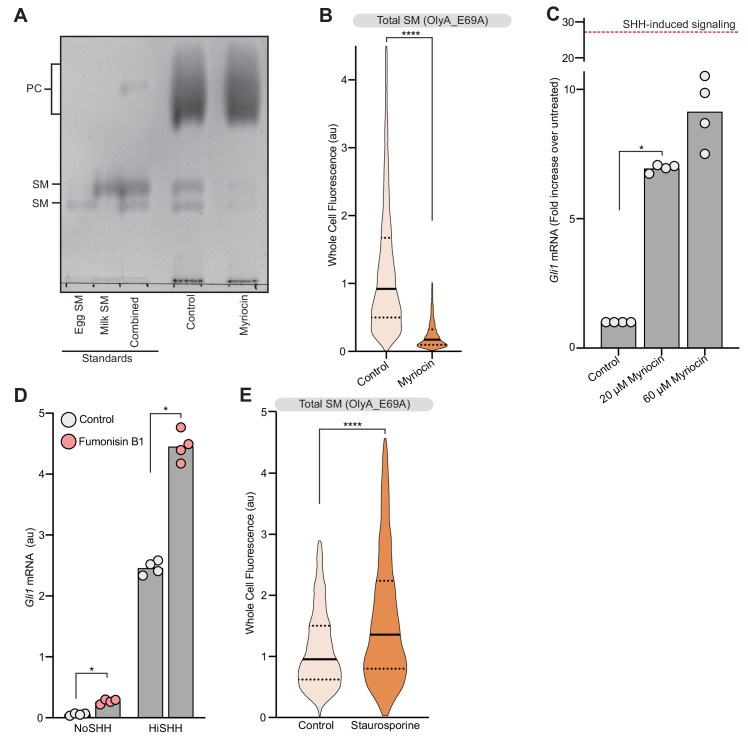
Analysis of sphingomyelin levels and their effect on hedgehog signaling.(A) Thin Layer Chromatography was used to measure SM and phosphatidylcholine (PC) levels in cells treated with myriocin. Purified egg and milk sphingomyelin were used as standards. (B) Flow cytometry was used to measure plasma membrane OlyA_E69A staining in intact NIH/3T3 cells after myriocin treatment (n > 4000 cells per treatment). (C) HH signaling triggered by myriocin alone in Smo-/- MEFs stably expressing wild-type SMO. Dotted red line indicates the magnitude of Gli1 mRNA induced by HiSHH (50 nM) treatment. (D) HH signaling triggered by fumonisin B1 (40 µM) in the presence or absence of HiSHH (25 nM) in NIH/3T3 cells. (E) Flow cytometry was used to measure plasma membrane OlyA_E69A staining in intact NIH/3T3 cells after staurosporine treatment (50 nM) (n > 4000 cells per treatment). In (C) and (D), bars denote the mean value derived from the four individual measurements shown. Statistical significance was determined by the Mann-Whitney test (B–E); p-values are: (B) p-value<0.0001, (C) p-value=0.0286, (D) p-value=0.0286 (both comparisons), and (E) p-value<0.0001.